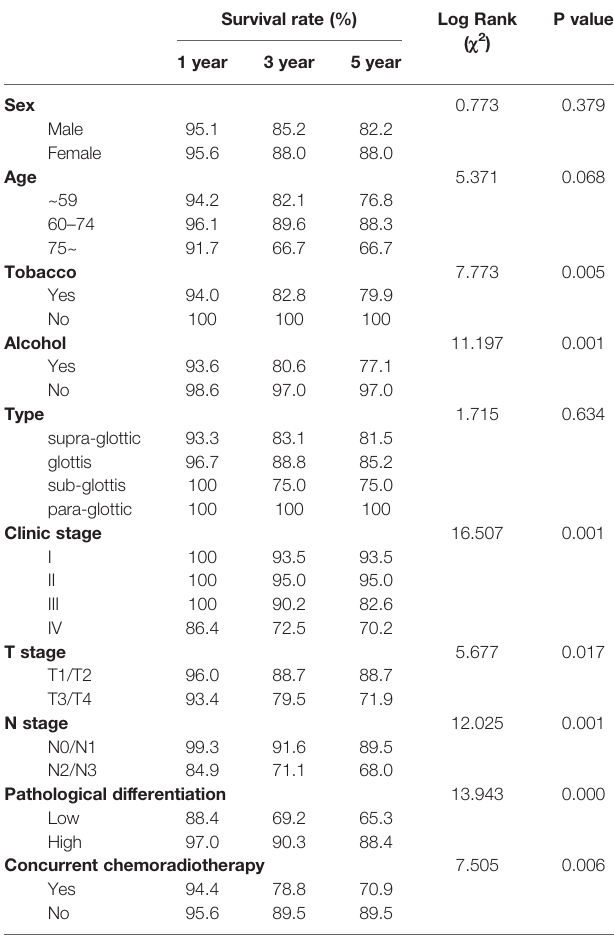
TABLE 2 | Survival rates and univariable analysis of Kaplan-Meier. Survival rate (%) Log Rank ( c 2